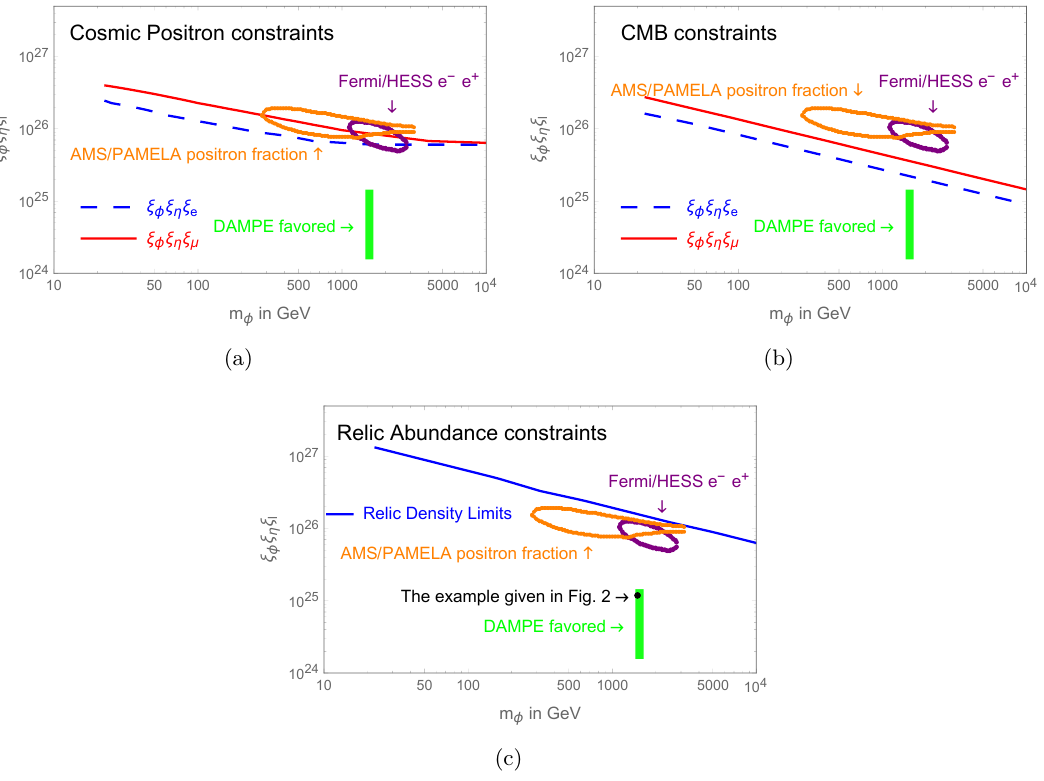
Figure 3 . In all figures, m η = 2 m φ − δ with δ = 0 . 01 GeV are fixed. The green region shows the possible DM explanation of the 1.5 TeV excess reported by DAMPE with 10 − 26 cm 3 / s ≤ h σv i ≤ 10 − 24 cm 3 / s. The 2 σ -preferred region suggested by the AMS/PAMELA φ,φ → η → e + ,e − positron fraction and Fermi/HESS electron and positron fluxes for the leptophilic φ, φ → η → µ + , µ − channel is surrounded by orange and purple contours, respectively [55]. (a) The upper lim- its constrained by the observation of the cosmic positron flux. (b) The upper limits constrained by the observation of the CMB. (c) The upper limits constrained by the DM relic